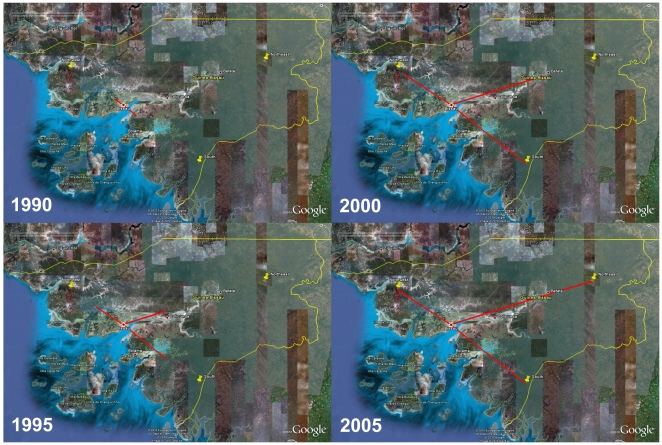
Temporal dynamics of spatial HIV-1 subsubtype A3 diffusion within Guinea-Bissau.Snapshots of the HIV-1 subsubtype A3 dispersal pattern within Guinea-Bissau. Lines between locations represent branches in the maximum clade credibility tree (MCC) along which well-supported location transitions occurs. The diffusion process was visualized in Google Earth (http://earth.google.com).